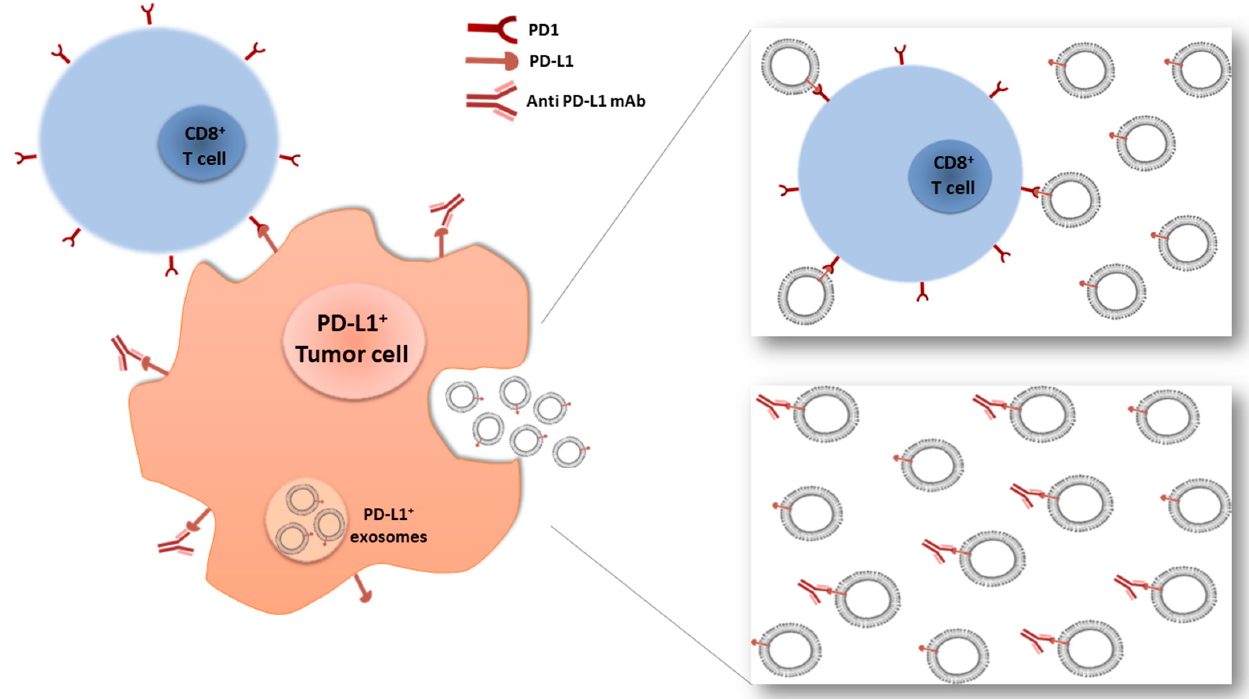
Figure 2. Exosomes-mediated immune-escape mechanisms. On the left is the mechanism of PD-L1+ tumor cell killing via PD1+/CD8+ T cell or anti-PD-L1 mAb binding. On the right are two possible mechanisms of acquired immunotherapy resistance mediated by PD-L1+ exosomes and secreted from the cancer cell: the direct binding between exosomes and T cells or between exosomes and anti PD-L1 monoclonal antibodies.